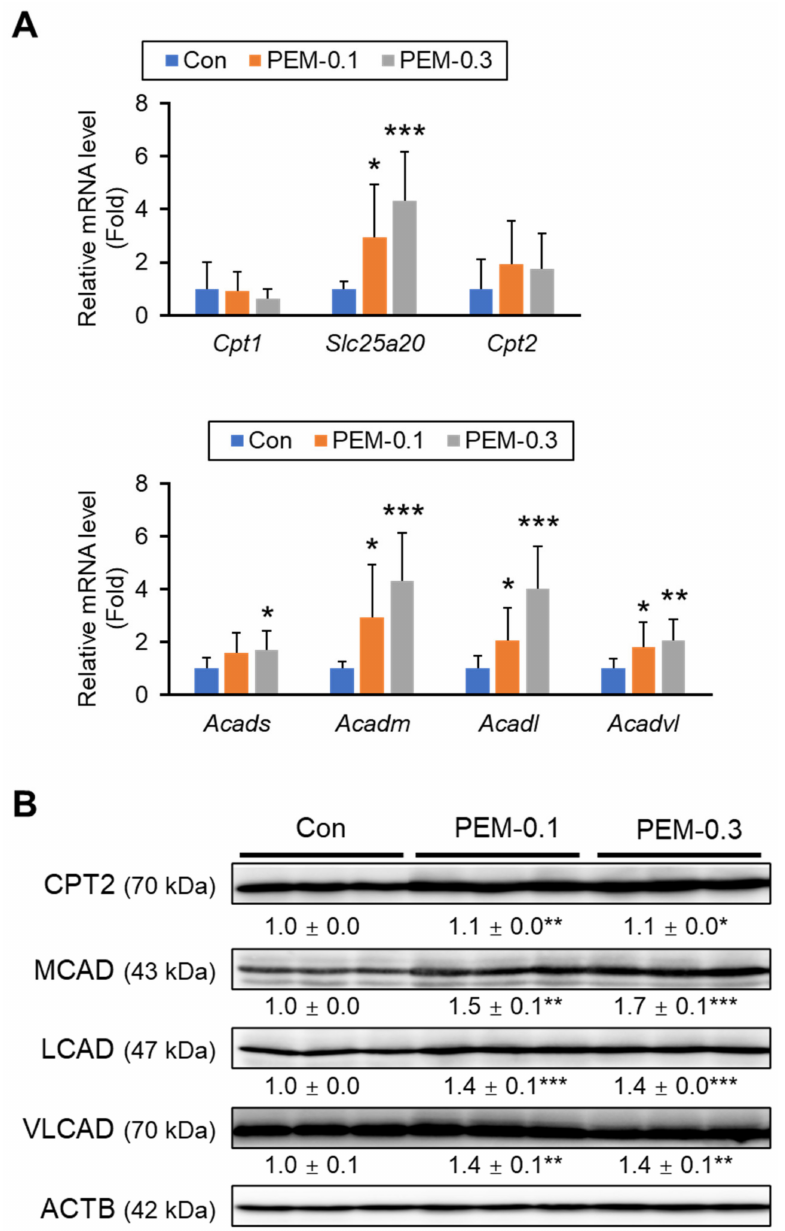
Figure 4. PEM augments mitochondrial FA β -oxidation in the liver. ( A ) Hepatic mRNA levels of genes related to mitochondria FA β -oxidation ( Cpt1 , Slc25a20 , Cpt2 , Acads , Acadm , Acadl , and Acadvl ) were quantified by qPCR, normalized to that of 18s ribosomal RNA, and expressed as values relative to those of control mice. ( B ) Immunoblot analysis of CPT2, MCAD, LCAD, and VLCAD. ACTB was used as a loading control. Band intensity was measured densitometrically, normalized to that of ACTB, and expressed as values relative to those of control mice. Results were obtained from two independent immunoblot experiments. Data are expressed as the mean ± SD. * p < 0.05, ** p < 0.01, and *** p < 0.001 vs. control group. Con, vehicle-treated mice; PEM-0.1, pemafibrate-treated mice at a clinically relevant dose (0.1 mg/kg/day); PEM-0.3, pemafibrate-treated mice at a relatively high dose (0.3